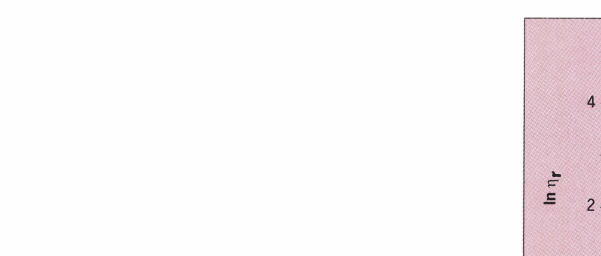
Abb. 2: Relative Viskositiit bei hohem Schergefiille als Funkti­ on vom ZnO-Gehalt Fig. 2: Relative viscosity at high shear ratesas a function of the ZnO content